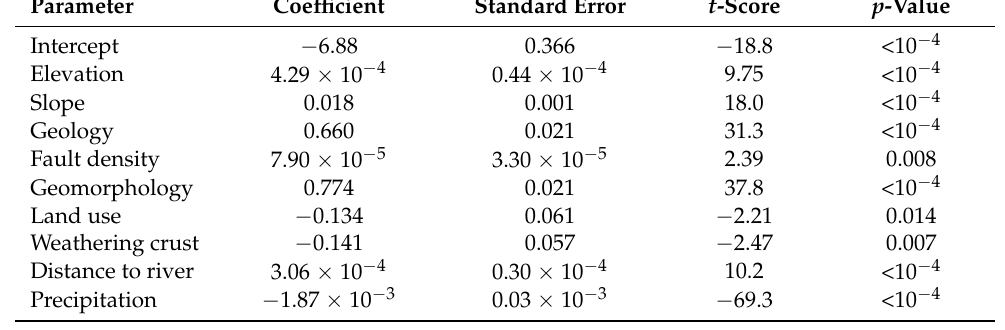
Table 2. Estimated coefficients of the logistic regression model, with standard error and corresponding Student’s t -statistic and p -value.